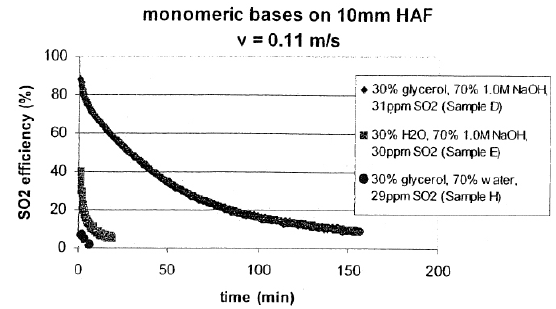
Figure 4. Evidence of some off-gassing of NH sample (Sample B).